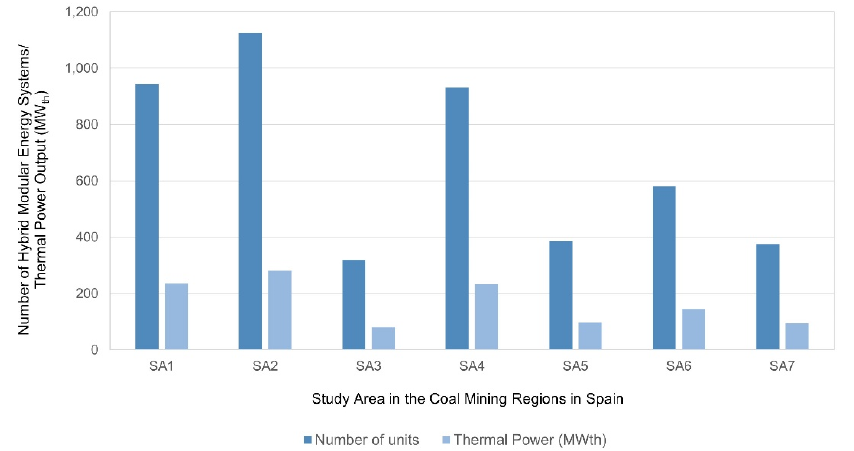
Figure 10. The number of potential hybrid-modular systems and power per sector.